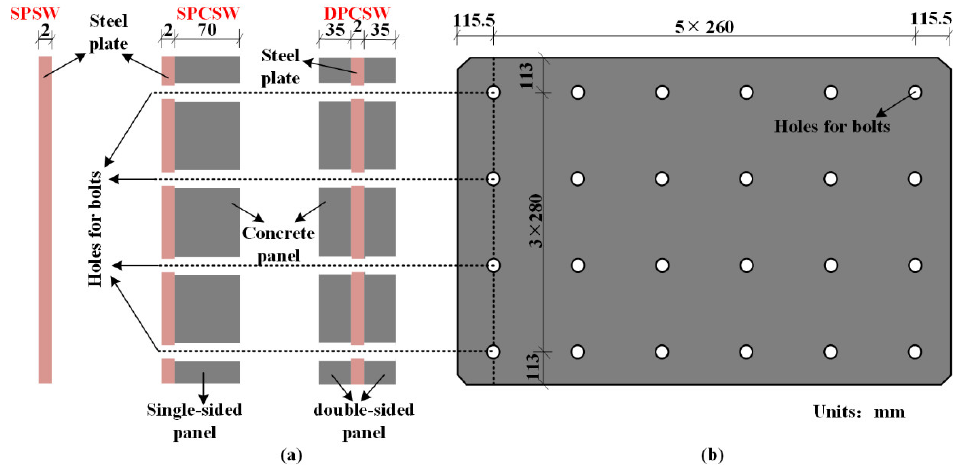
Figure 4. Composition of composite shear walls: ( a ) side view; ( b ) front view.